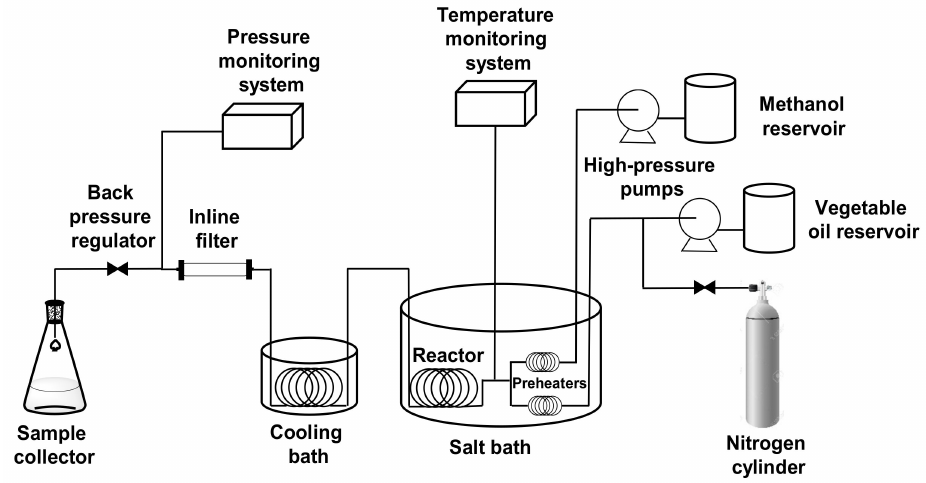
Figure 25. Tubular flow reactor.